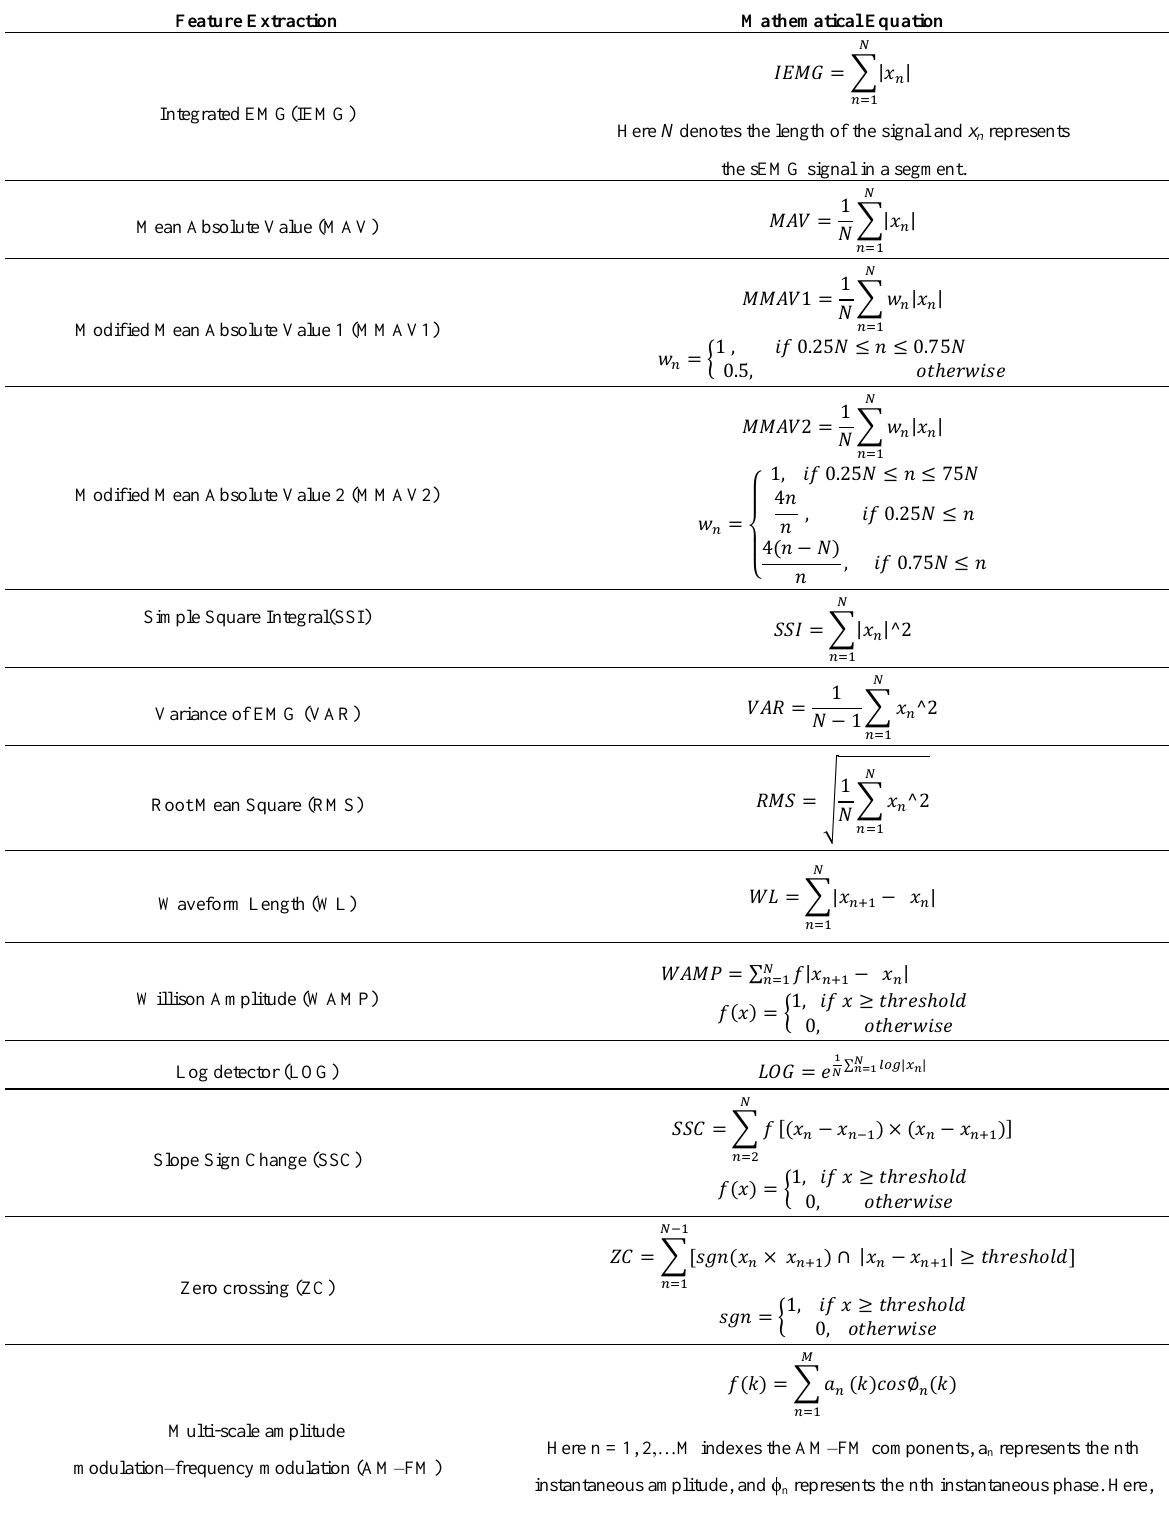
Table 4. Mathematical representation of widely used sEMG feature extraction